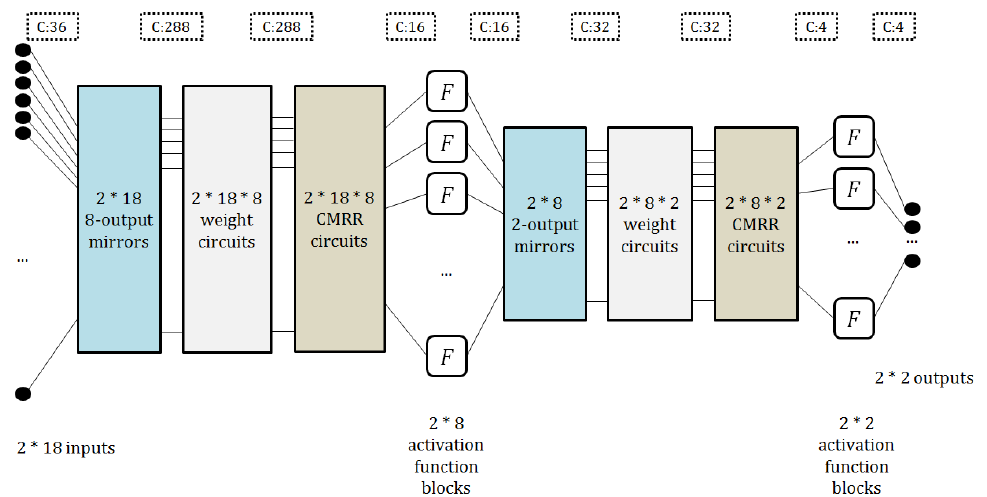
Figure 13. The structure of the preprocessor with a division into blocks: multipliers, duplicators, CMRR removal circuits and blocks implementing activation